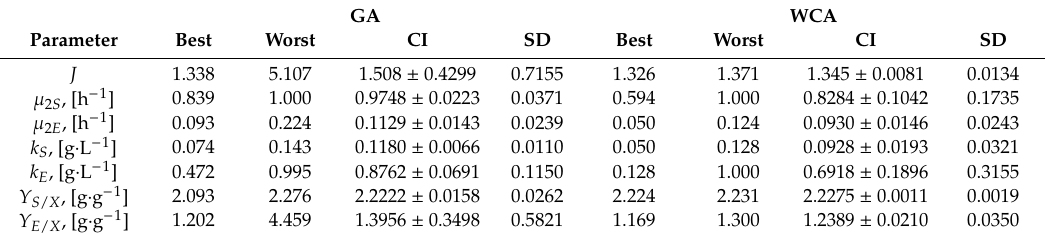
Table 3. Case study 2 : Comparison of the results obtained by GA and WCA. GA WCA Parameter Best